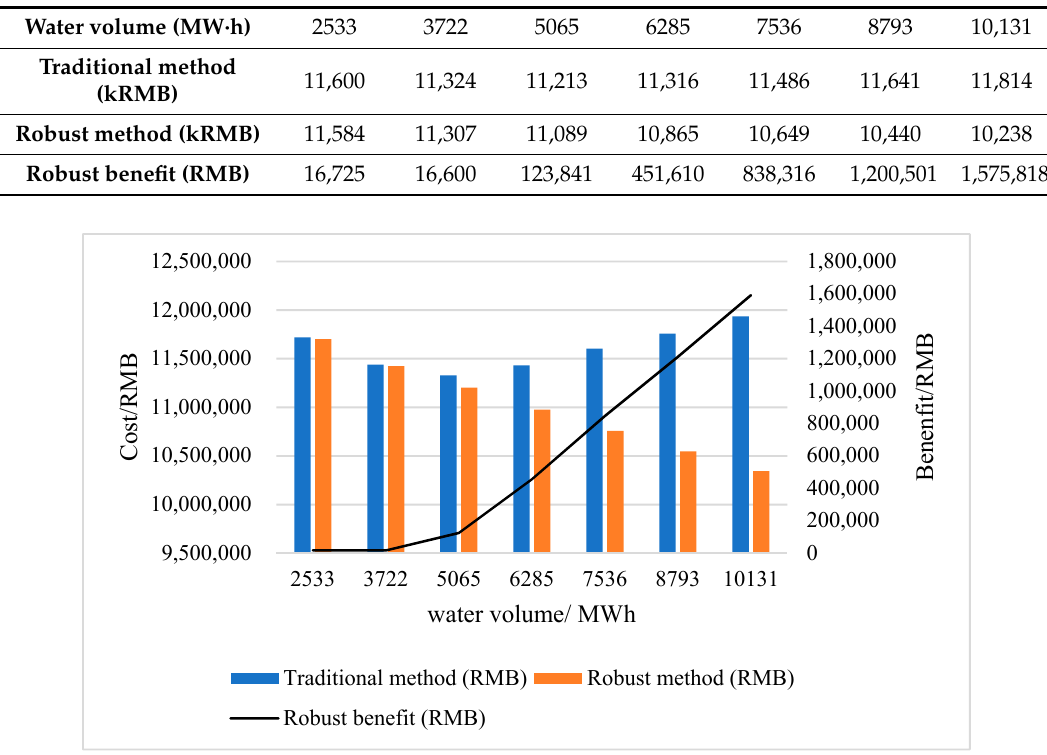
Figure 8. Robustness benefit after increasing water quantity.